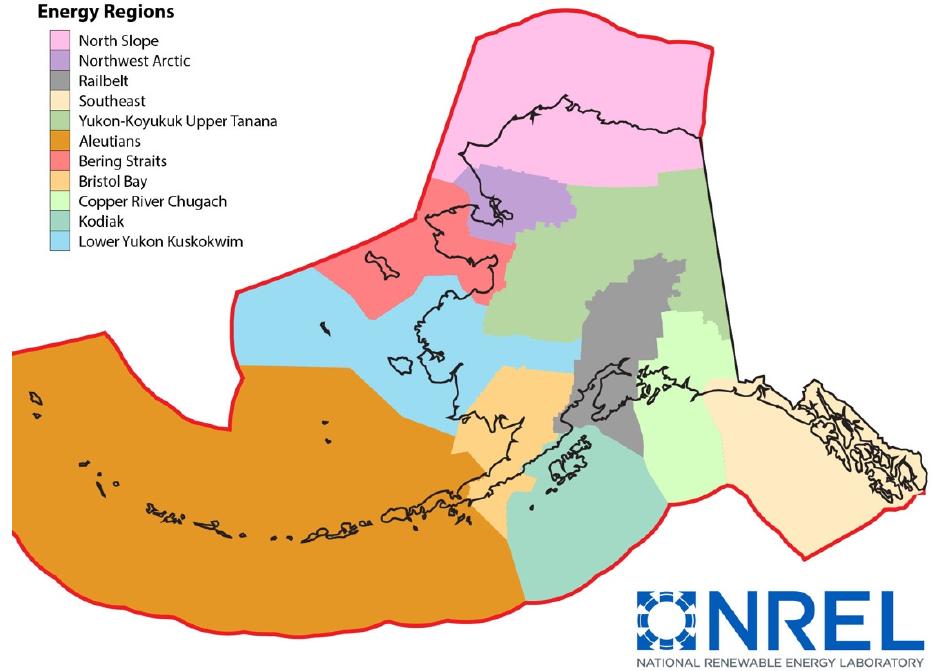
Figure 3. Map of the AEA’s 11 onshore energy regions, extended outward by NREL to offshore regions to the EEZ limit.